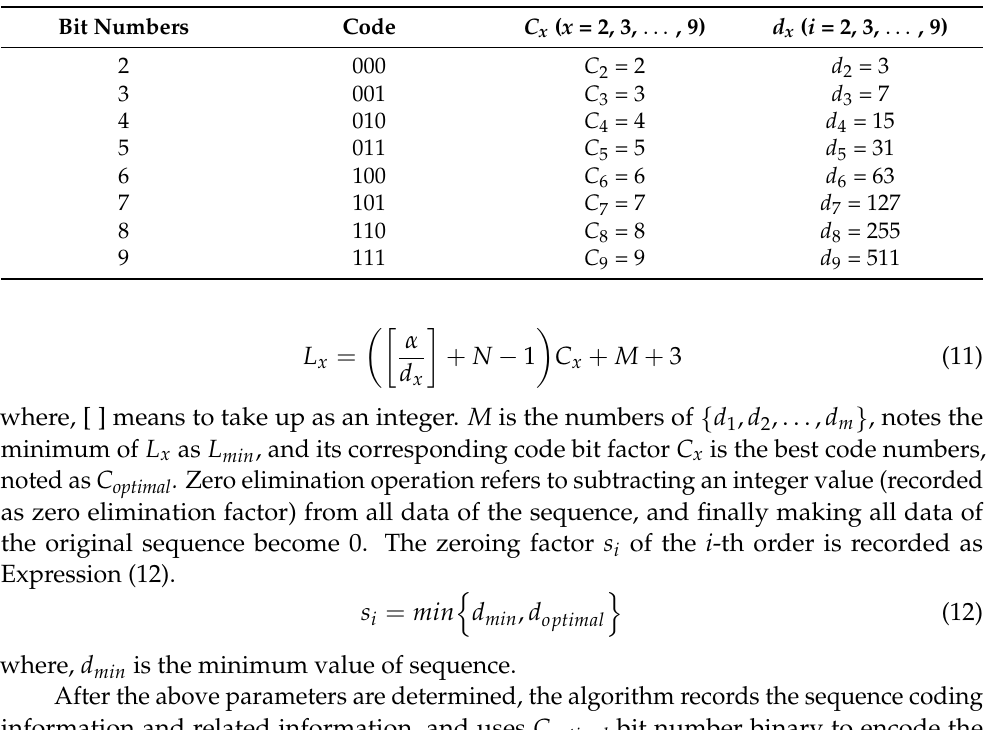
Table 1. The relationship of bit numbers, code, C x and d i .